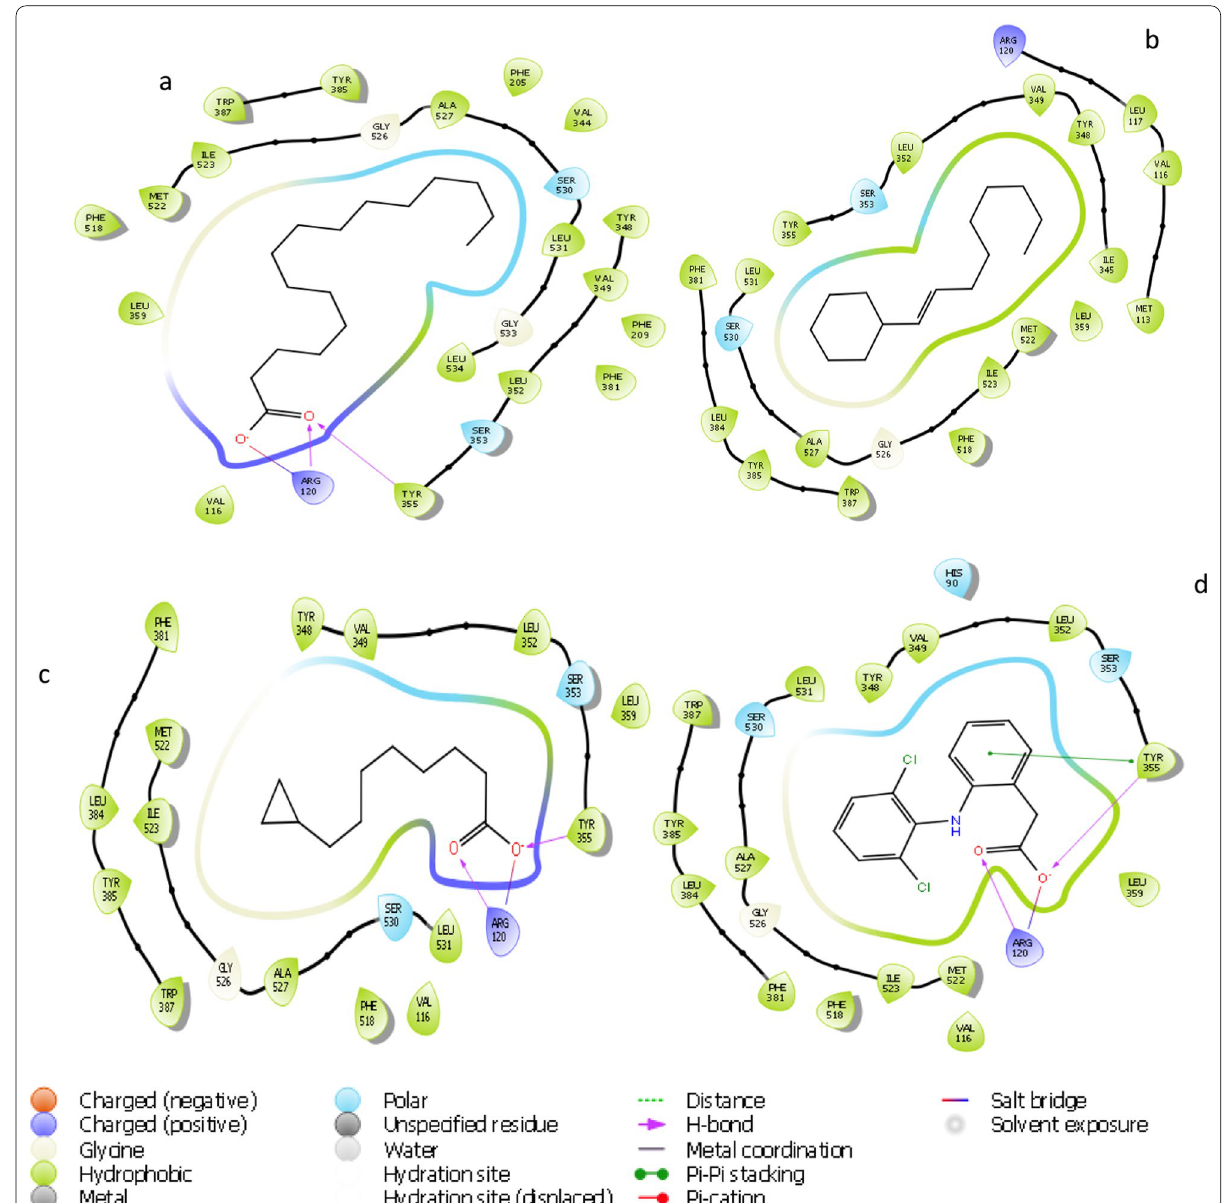
Fig. 3 2D molecular contacts profiling for the last poses of Cox-1-hit compounds, viz. a Hexadecanoic acid, b 1-cyclohexylnonene, c Cyclopropoxylactonoic acid, d